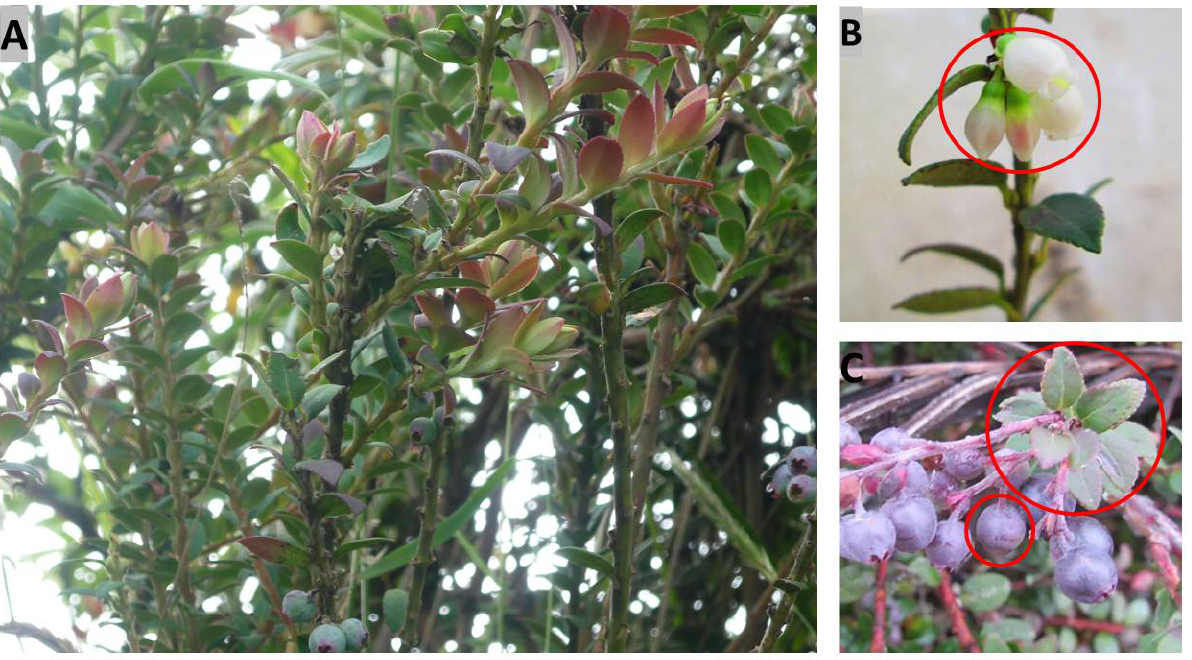
Figure 3. Mortiño plant ( Vaccinium floribundum Kunth) with its floral primordia ( A ), A small bunch of flowers with some pigmentation ( B ), Serrated leaves and its ripe berries ( C ). Source: This article.